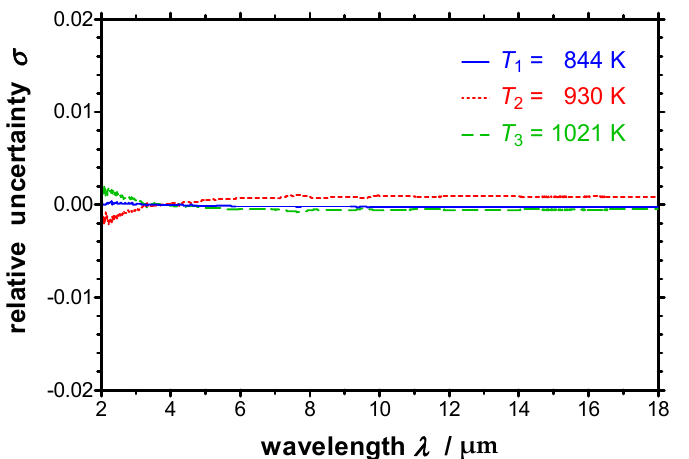
Figure 2. Typical calibrating functions C 1 and C 2 derived from a calibration of the apparatus versus wavelength.